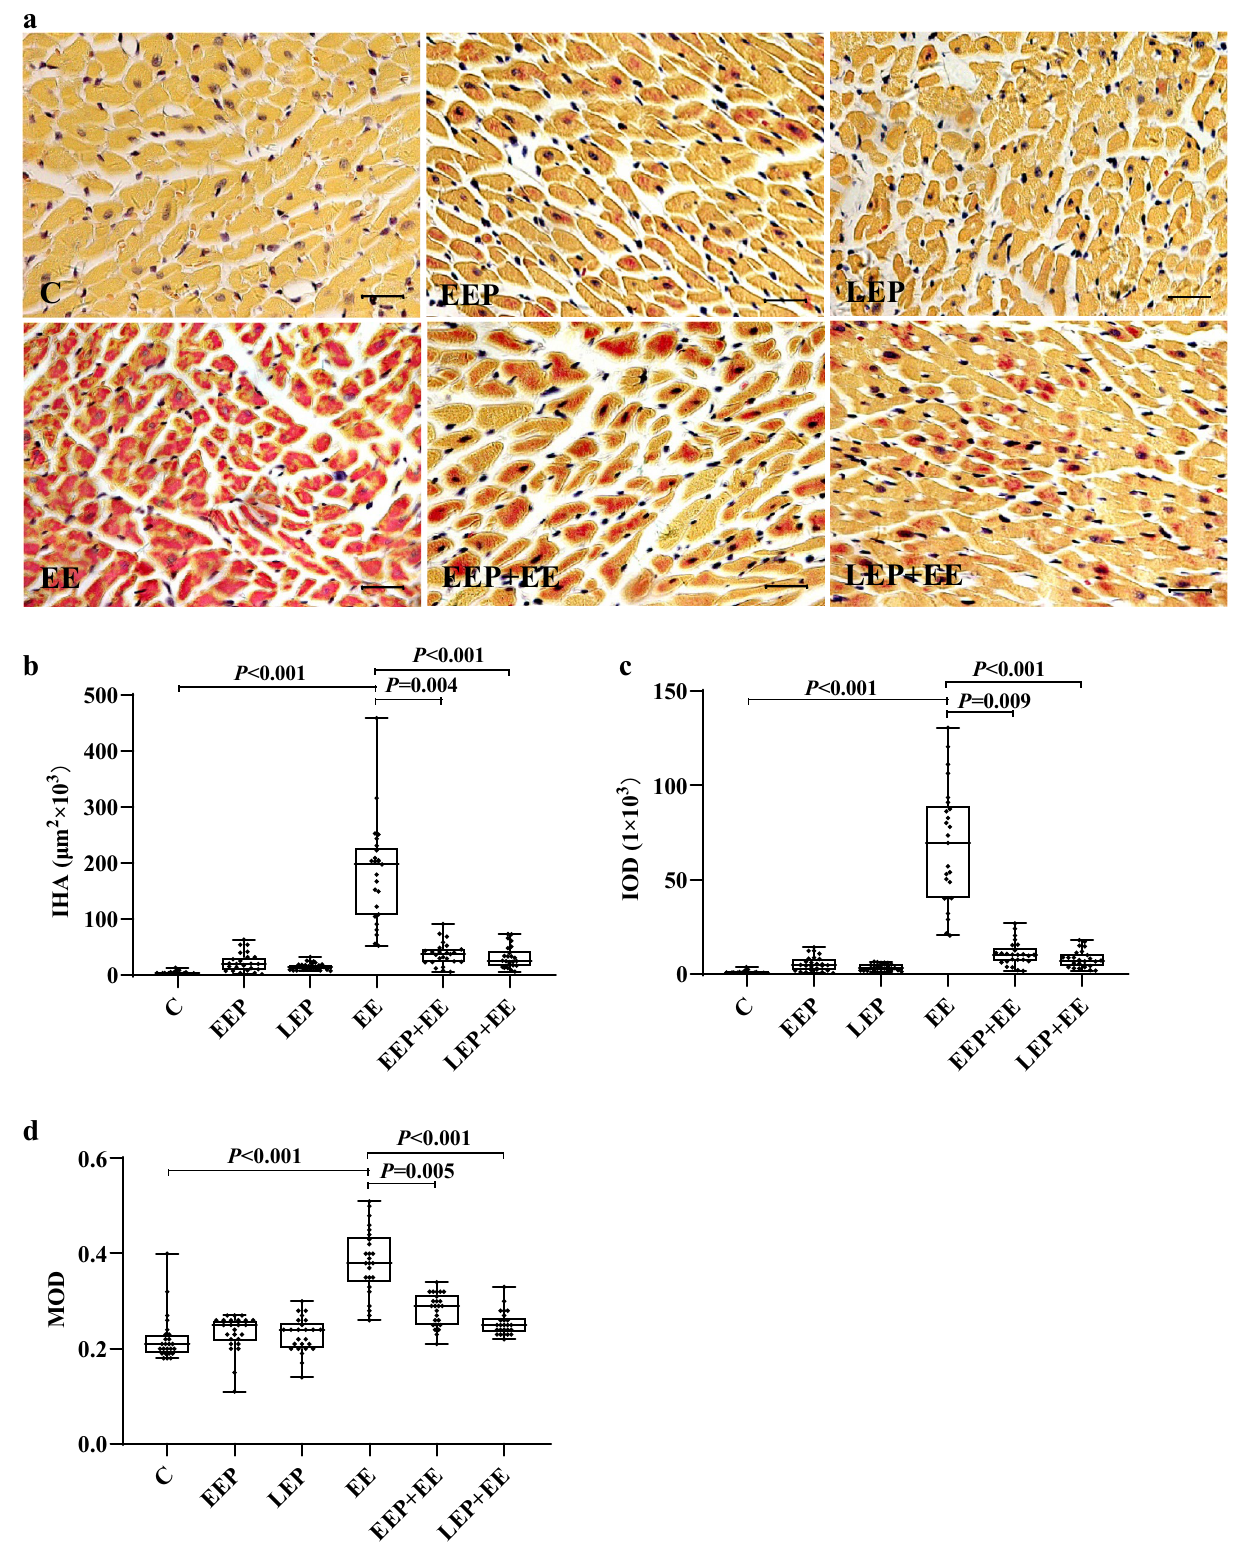
Figure 4. Analysis of the myocardium in HBFP staining images. ( a ) The results of HBFP staining of the myocardium (scale bar: 20 μm). There were a large number of scarlet-stained cardiomyocytes in group EE. The number of scarlet-stained cardiomyocytes was obviously reduced in the EEP + EE and LEP + EE groups. ( b ) The analysis of IHA in HBFP staining images (K-W test). ( c ) The IOD of HBFP staining images (K-W test). ( d ) The MOD of HBFP staining images (K-W test). The IHA, IOD, and MOD were significantly elevated in group EE. Compared with those in group EE, the IHA, IOD, and MOD in group EEP + EE and group LEP + EE were significantly lower. The results suggested that exhaustive exercise induces severe ischemic/hypoxic injury in the myocardium and that EP can effectively mitigate the ischemic/hypoxic injury caused by exhaustive